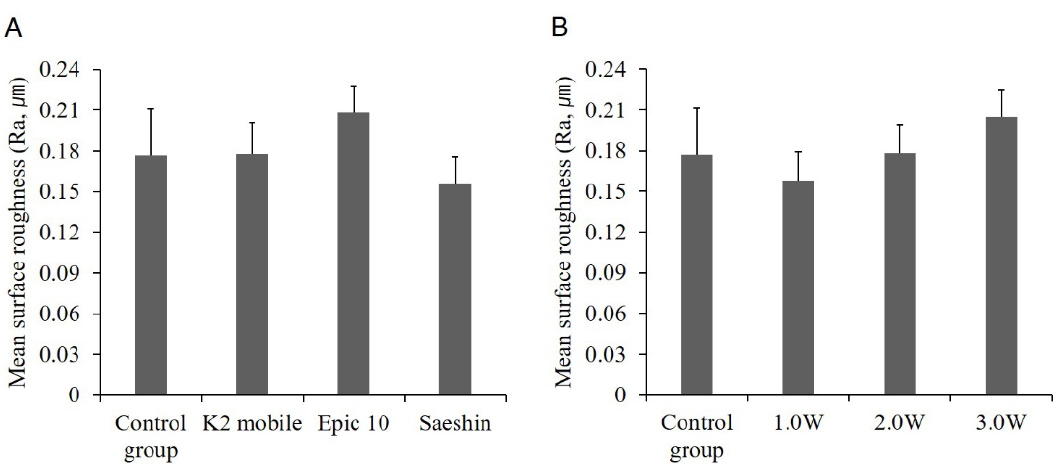
Figure 3. Bar diagrams showing the difference in mean surface roughness (Ra) values according to laser types and output powers: ( A ) a comparison of mean Ra values between various laser types, ( B ) a comparison of mean Ra values between various output powers.